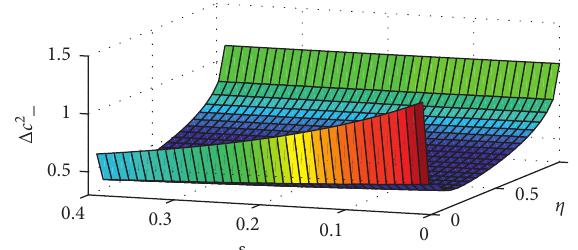
Figure 5: A plot of the minus quadrature variance (equation (25)) versus ε and η for A � 100, κ � 0 . 8, and n th � 0 .